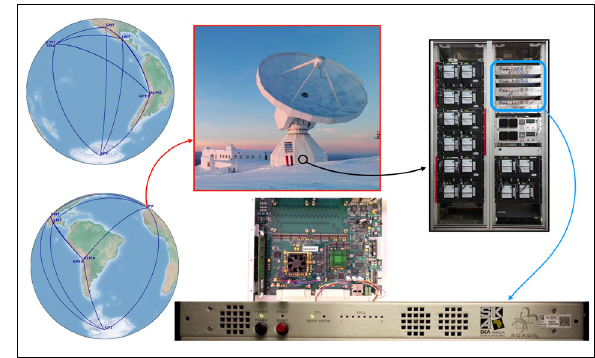
Figure 1: The 2017 EHT network as viewed from the centre of the Milky Way (left). The IRAM Pico Veleta 30-metre antenna in Spain (top middle), with the EHT VLBI backend deployed at all EHT stations (top right), which include South African developed ROACH2 digital backend boards (bottom).